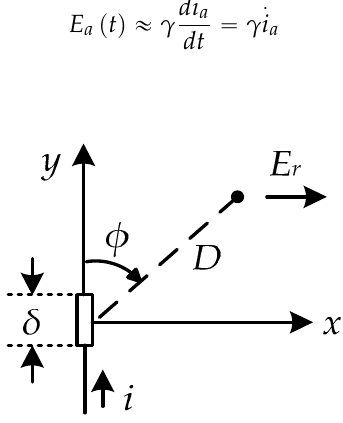
Figure 5. The electromagnetic field along the x -axis.